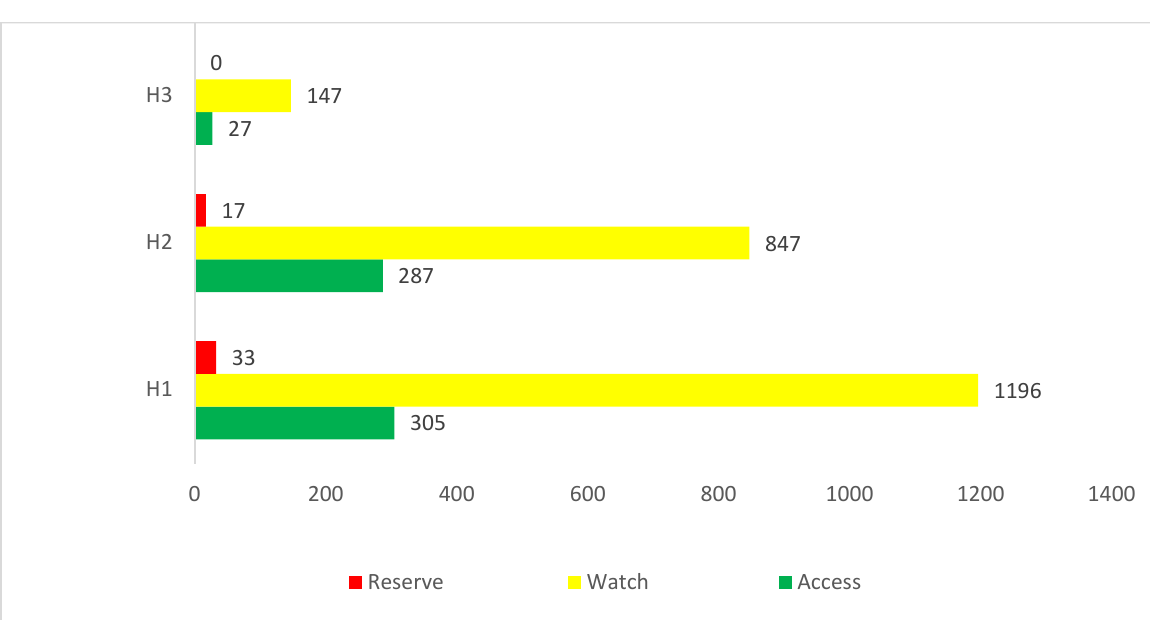
Figure 1. Antibiotics use according to WHO AWaRe classification.